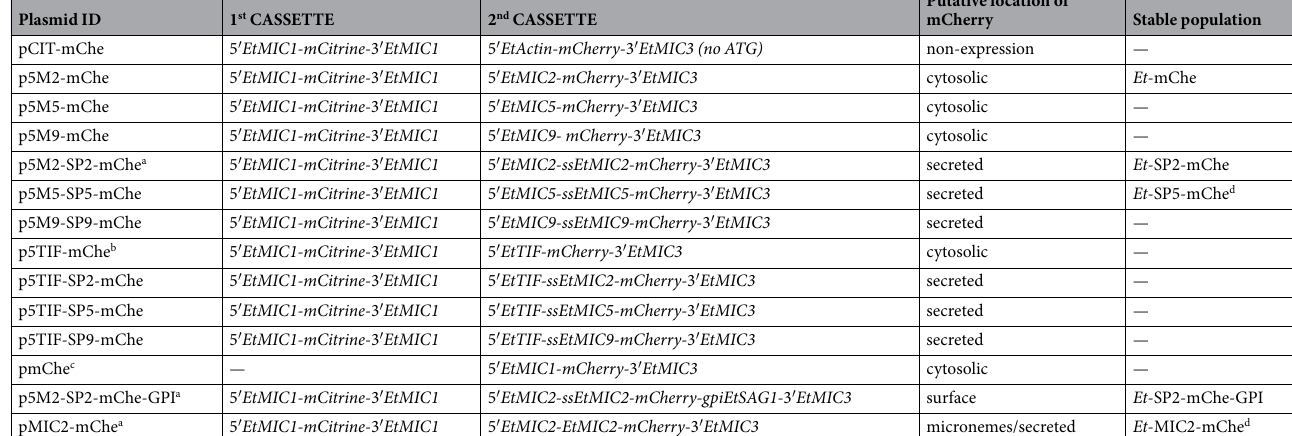
Table 2. List of plasmids used in the study and their principal features. a Used to obtain stable populations: Et - SP2-mChe, Et -SP2-mChe-GPI and Et -MIC2-mChe; respectively. b Marugan-Hernandez et al . 4 . c Clark et al . 47 . d Not characterised in the